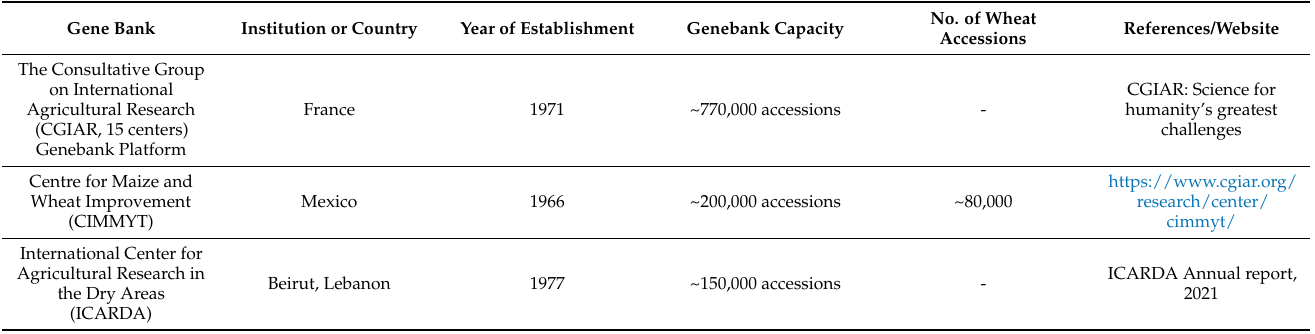
Table 2. Important gene banks and databases of small grains, including wheat, as sources of PM